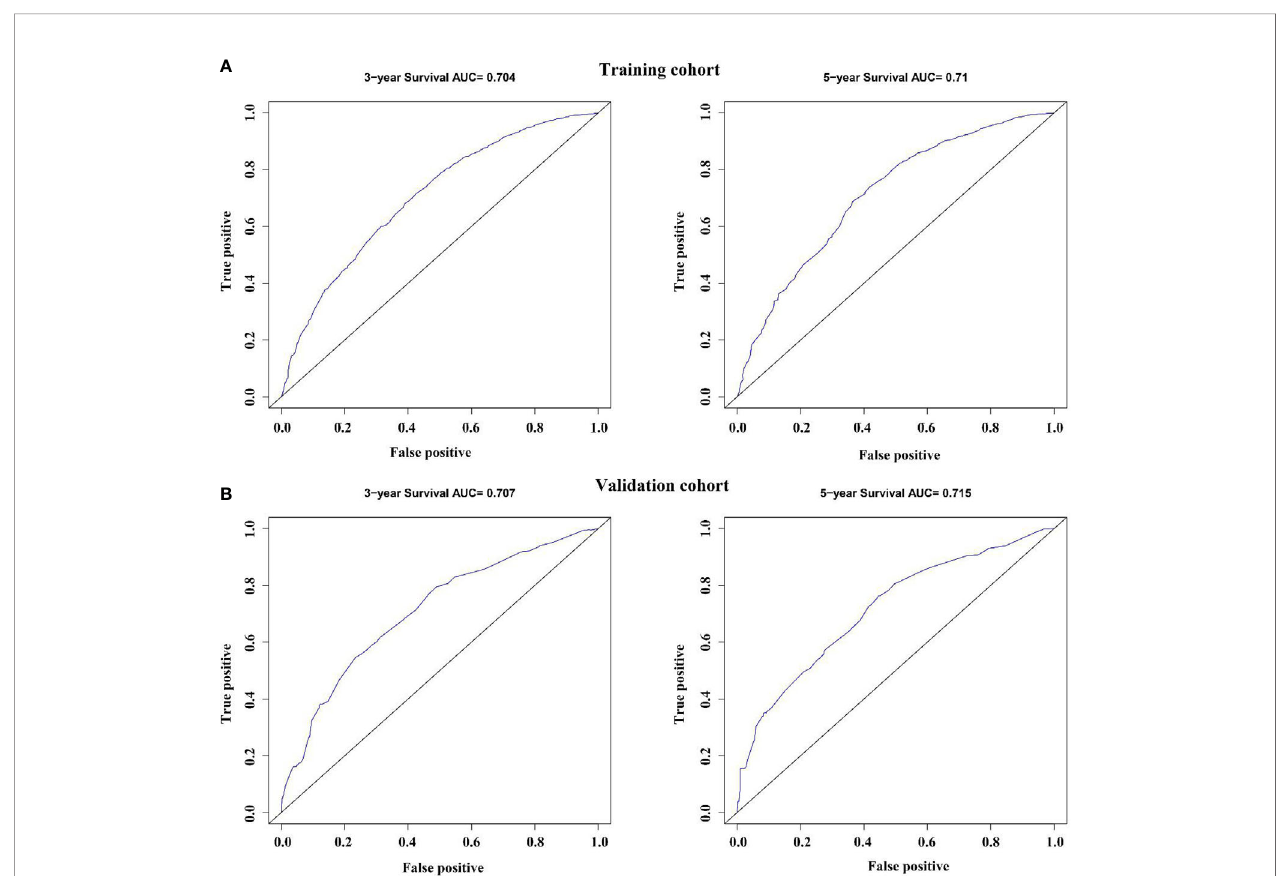
FIGURE 6 | Validation of the nomogram via the receiver operating characteristic curves. (A) Training cohort; (B) Validation